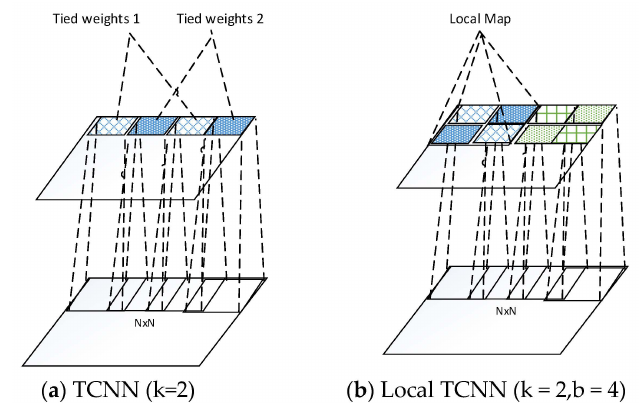
Figure 4. The convolutional layer of TCNN and proposed local TCNN. Units with same colour and fill are weights